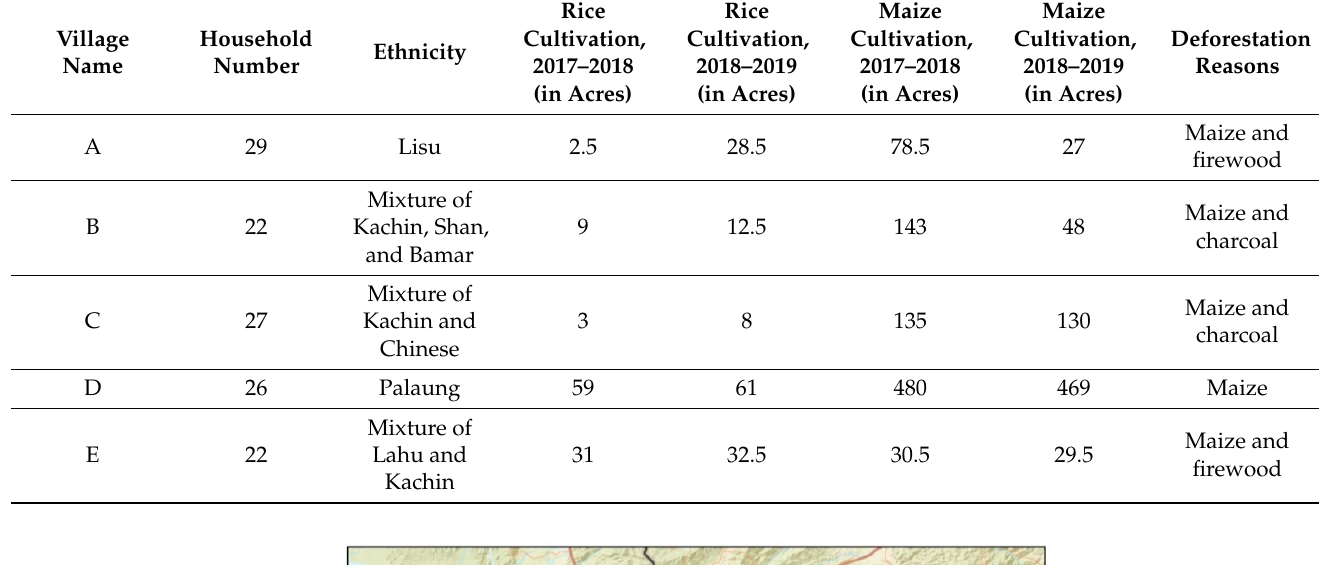
Table 1. Profiles of the five villages and their agricultural activities.